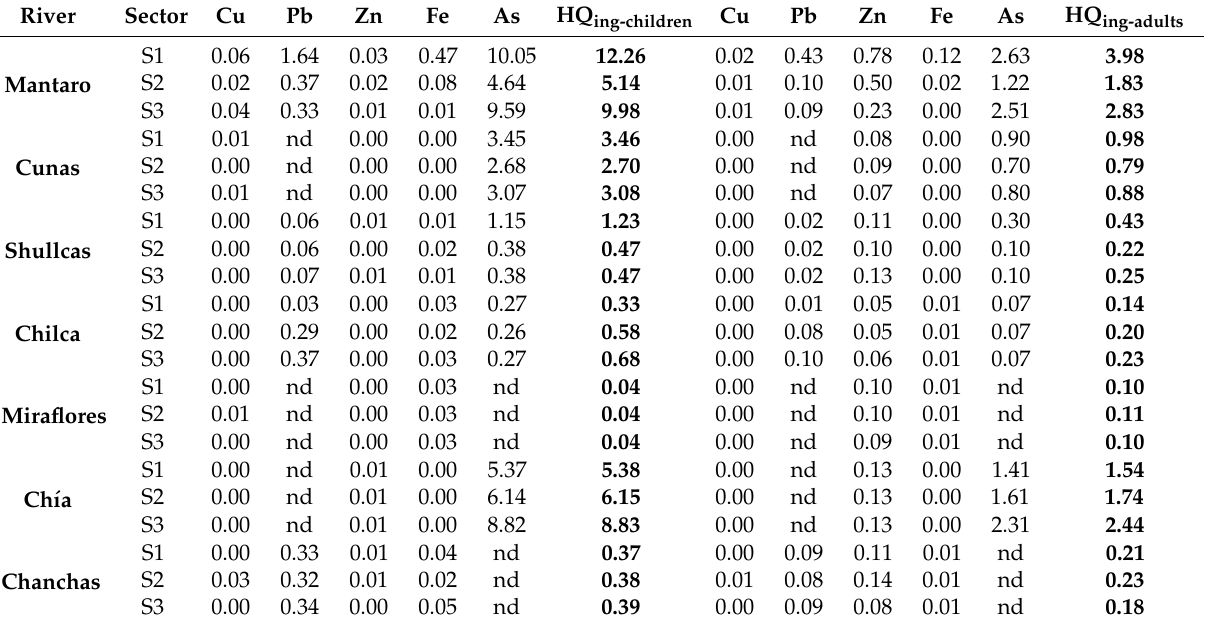
Table 3. Non-carcinogenic risk by ingestion (HQ ing and HQ ing ) of heavy metals and arsenic in river water subject to mining influence (children and